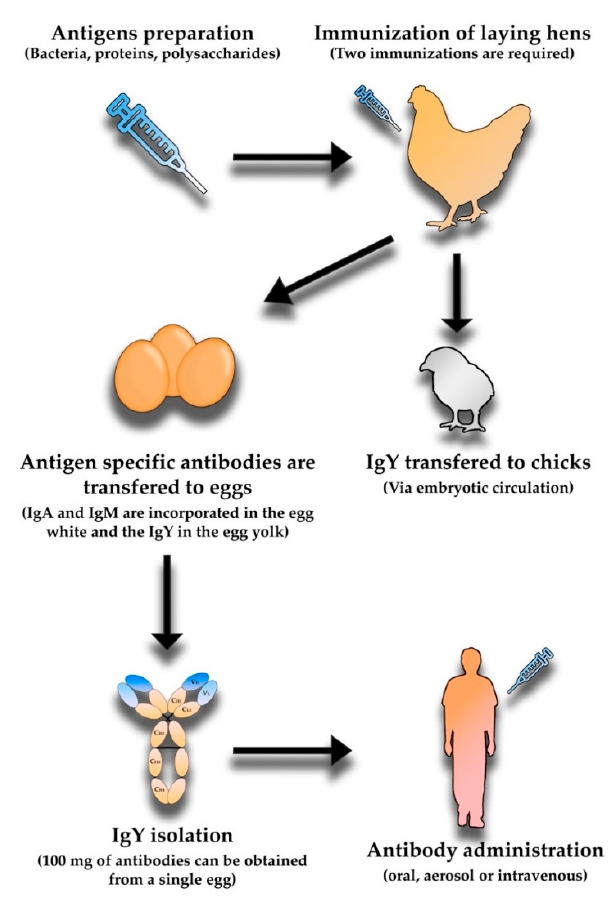
Figure 3. Summary of polyclonal IgY production process.